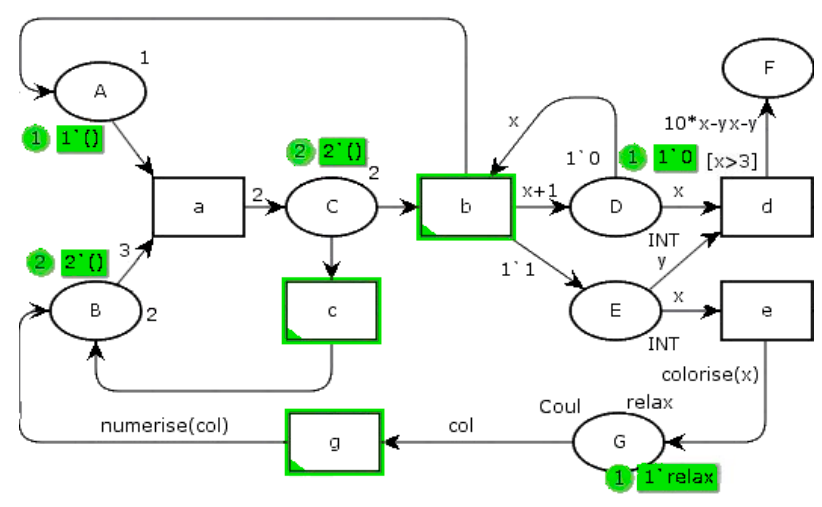
Figure 3. Colored Petri net example.